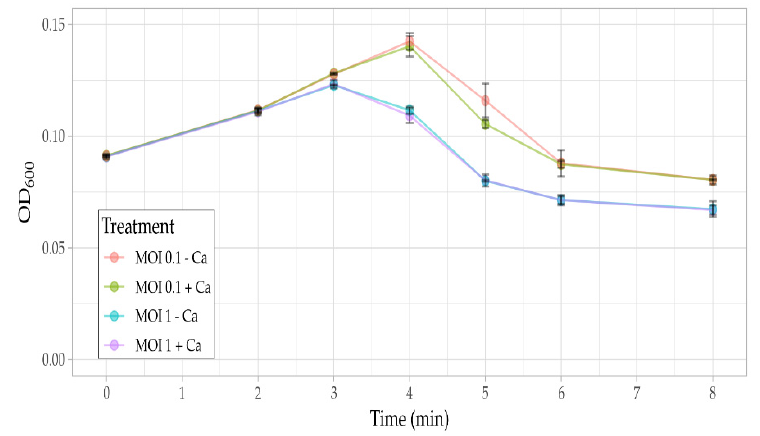
Figure 6. Lysis of S. maltophilia AP143S by Ps15 (MOI 0.1) in tryptone soy broth at 37 °C, with (10 mM) and without the addition of calcium chloride ions. Error bars indicate the standard deviation of triplicates.